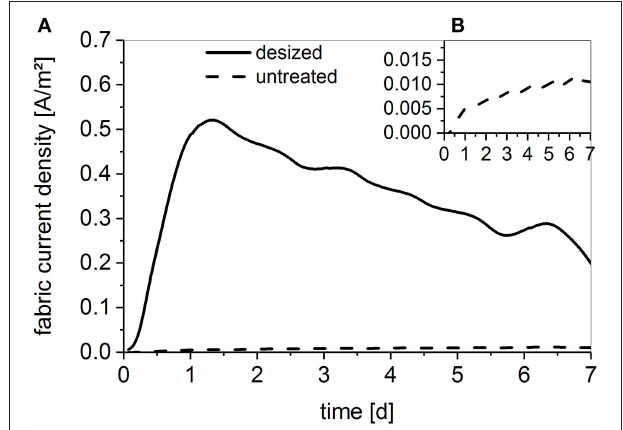
FIGURE 2 | (A) Bacterial current generation on T300 plain woven fabrics (average from n = 2); straight lines, pyrolytically desized (N 2 atmosphere); dashed lines, untreated (with intact sizing). Insert (B) shows untreated fabrics with smaller y-axis scale.